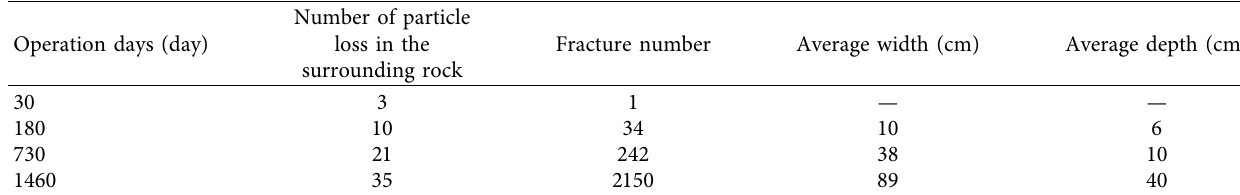
Table 5: Development table of cavity deterioration of base